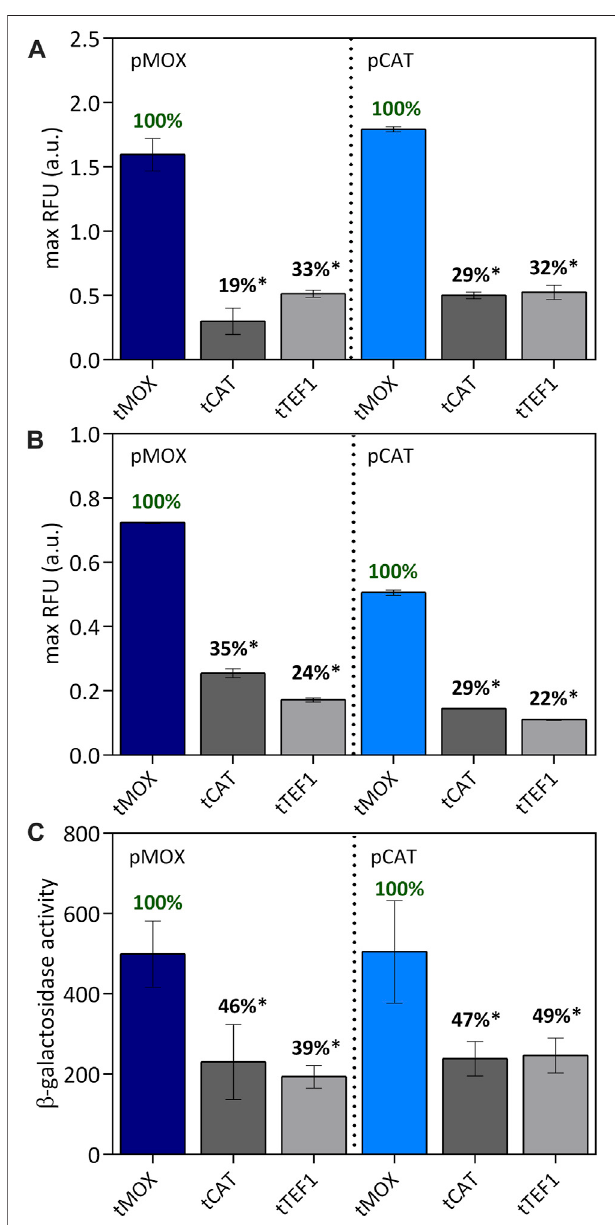
FIGURE6| CombinationoftMOX,tCATandtTEFwithpMOXandpCAT on methanol (A) causing an equally strong induction of the promoters and on glycerol (B) causing a medium-strong induction for pMOX and a weak induction for pCAT. The maximum relative fl uorescence units are shown here. Thestrongest terminator wasset to100% foreach promotertoallow an easy comparison within one group of promoters. In (C) the β -galactosidase activity was determined for the promoter-terminator combinations on methanolasacarbonsource.Statisticalsigni fi cance(indicatedwith*when p < 0.05) was tested with an unpaired t -test between the max RFU of the various promoters-terminator pairs and the highest max RFU ofthe dataset (pMOX or pCAT 100% indicated in green) Supplementary Table S8